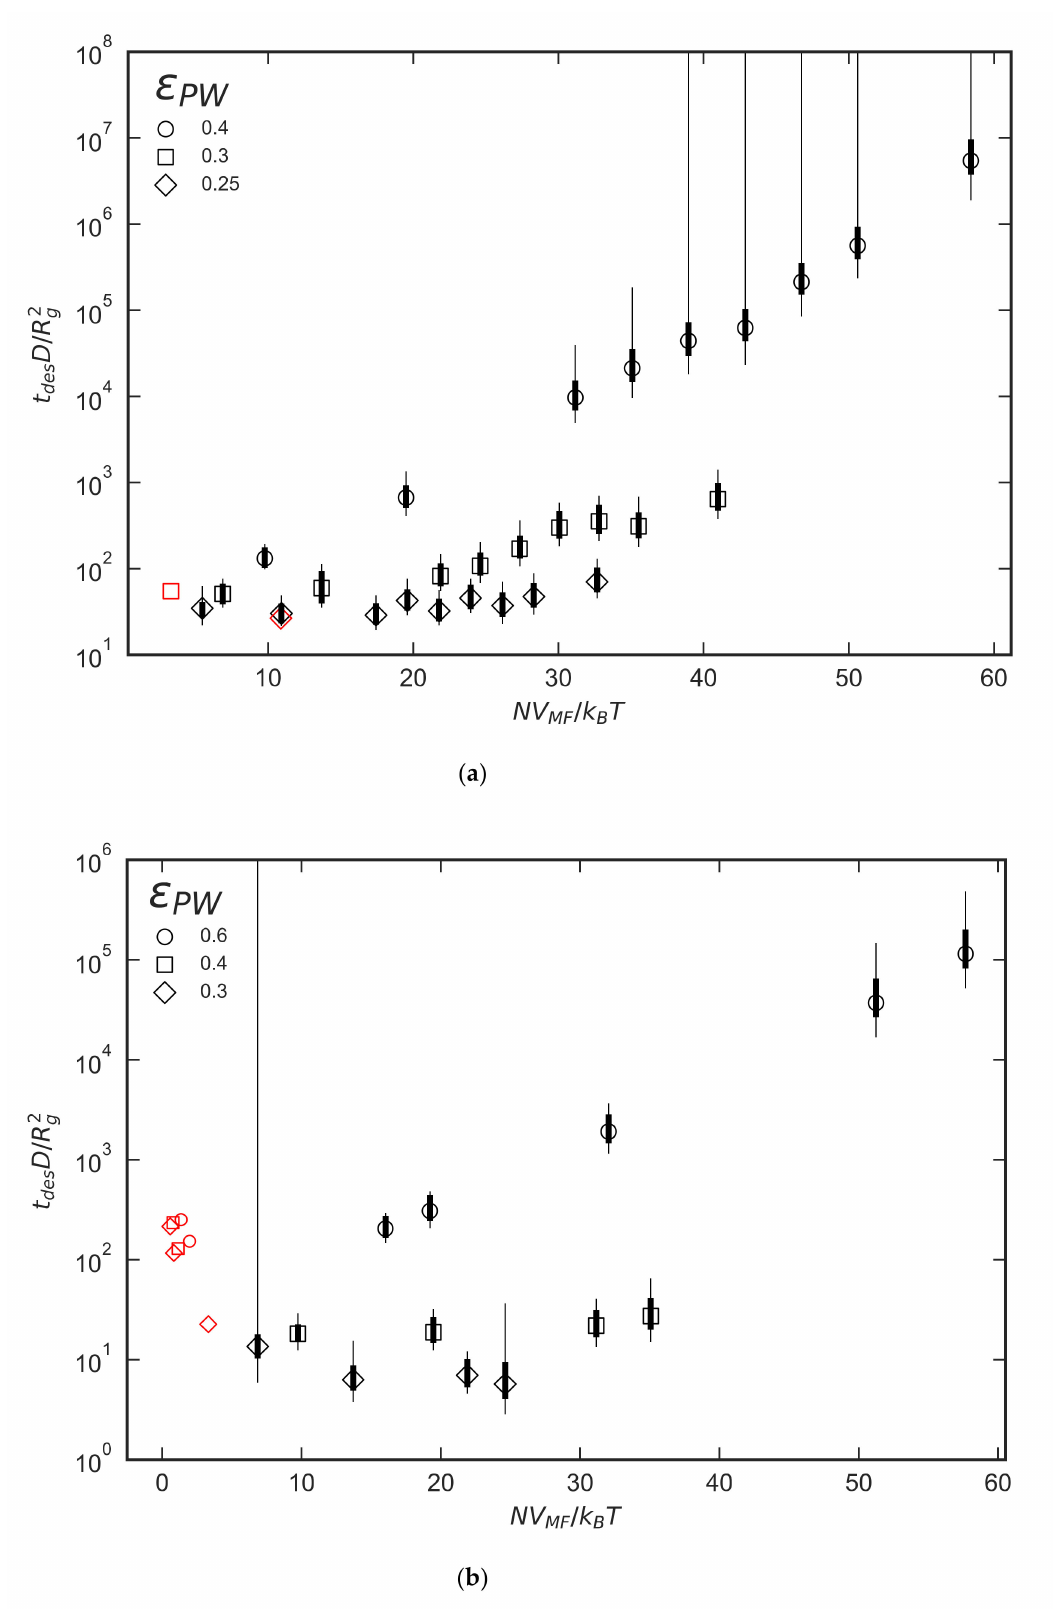
Figure 8. Plot of dimensionless desorption time vs. NV MF for ( a ) FJC and ( b ) FJC + EV polymers. FFS results are colored black and brute-force results are colored red. ε PW is in units of kJ / mol. The thick error bars are based on Equation (12), and the thin ones are based on the conservative assumption that any common ancestor leads to perfect correlation between descendants, as discussed in the